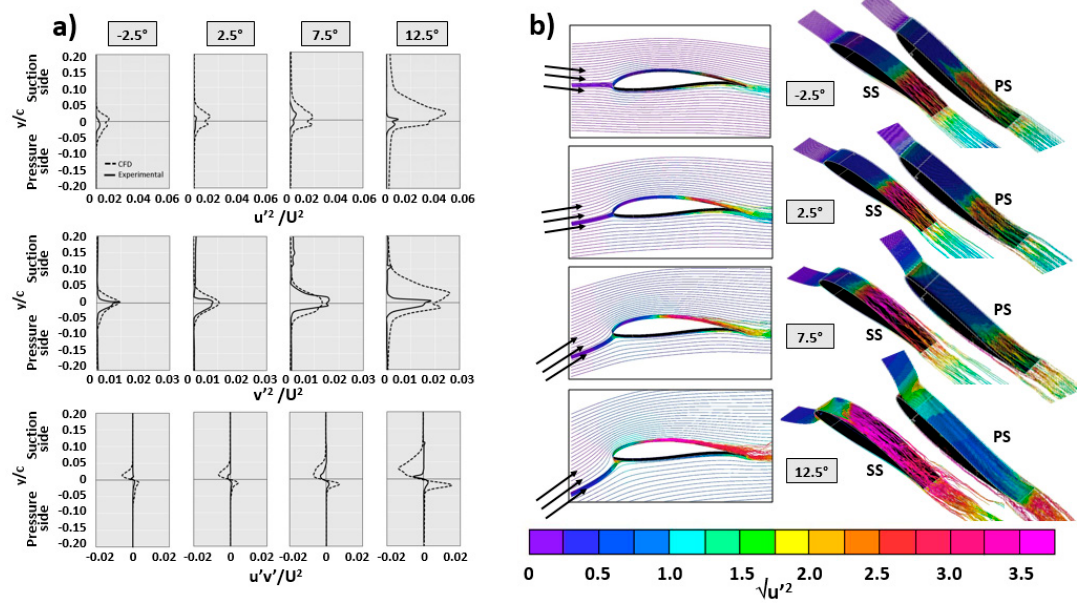
Figure 8. ( a ) Comparison between numerical and experimental results for the transversal distributions of the Reynolds stresses at different angles of attack. ( b ) Numerical streamlines colored by the intensity of turbulent fluctuations.